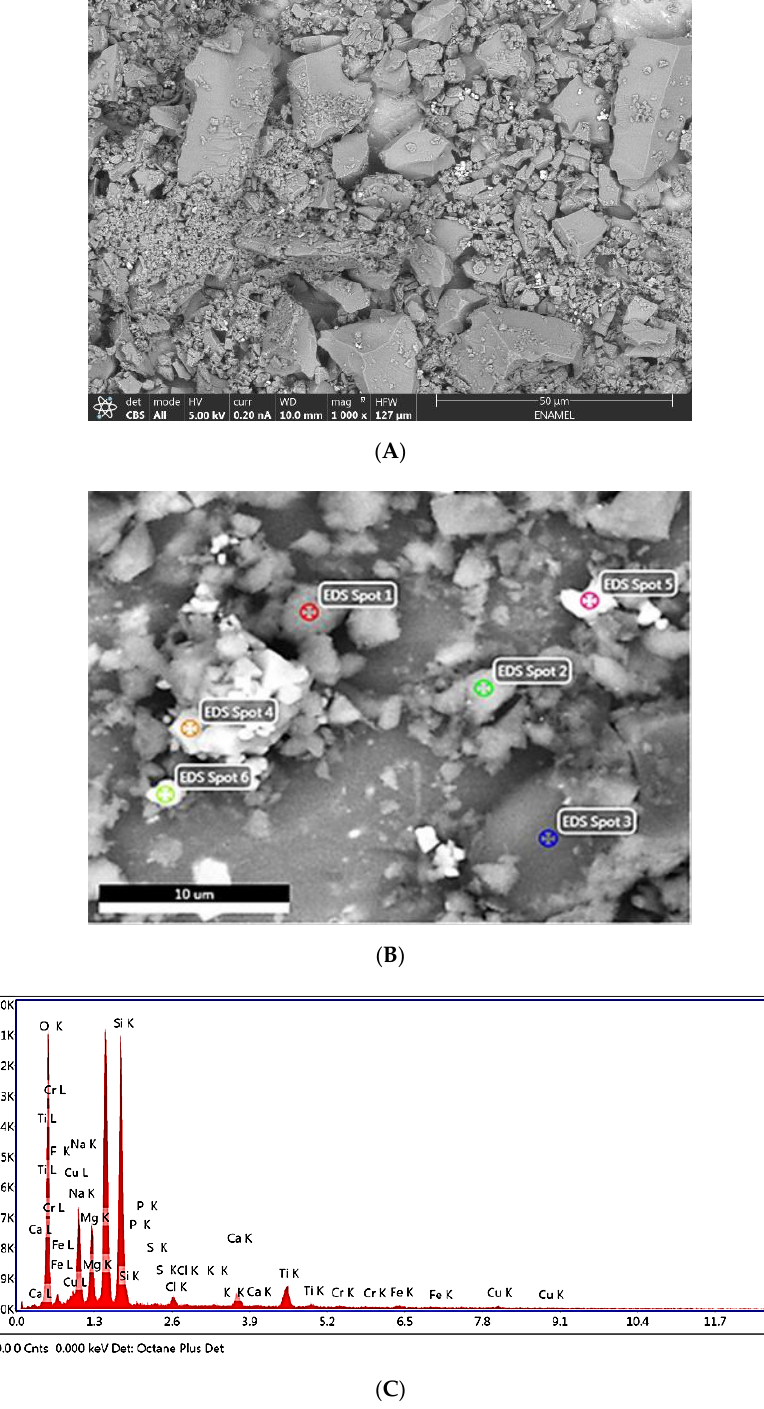
Figure 5. ( A ) SEM micrograph of enamel powder, ( B ) micrograph of EDS study, and ( C ) EDS on spot 1 of Figure 5B.